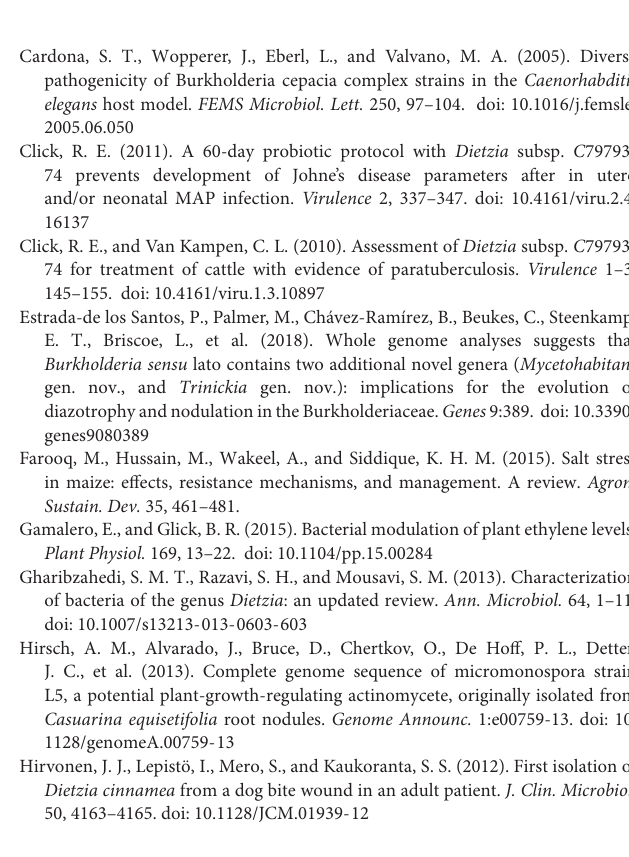
FIGURE S1 | Salt (A) and PEG-induced drought (B) stress tolerance of D. cinnamea 55. FIGURE S2 | Photographs of siderophore production, and xylanase and cellulase activity of D. cinnamea 55. FIGURE S3 | Photographs of Galleria mellonella assay plates (i) , and alfalfa plants (ii) treated with D. cinnamea